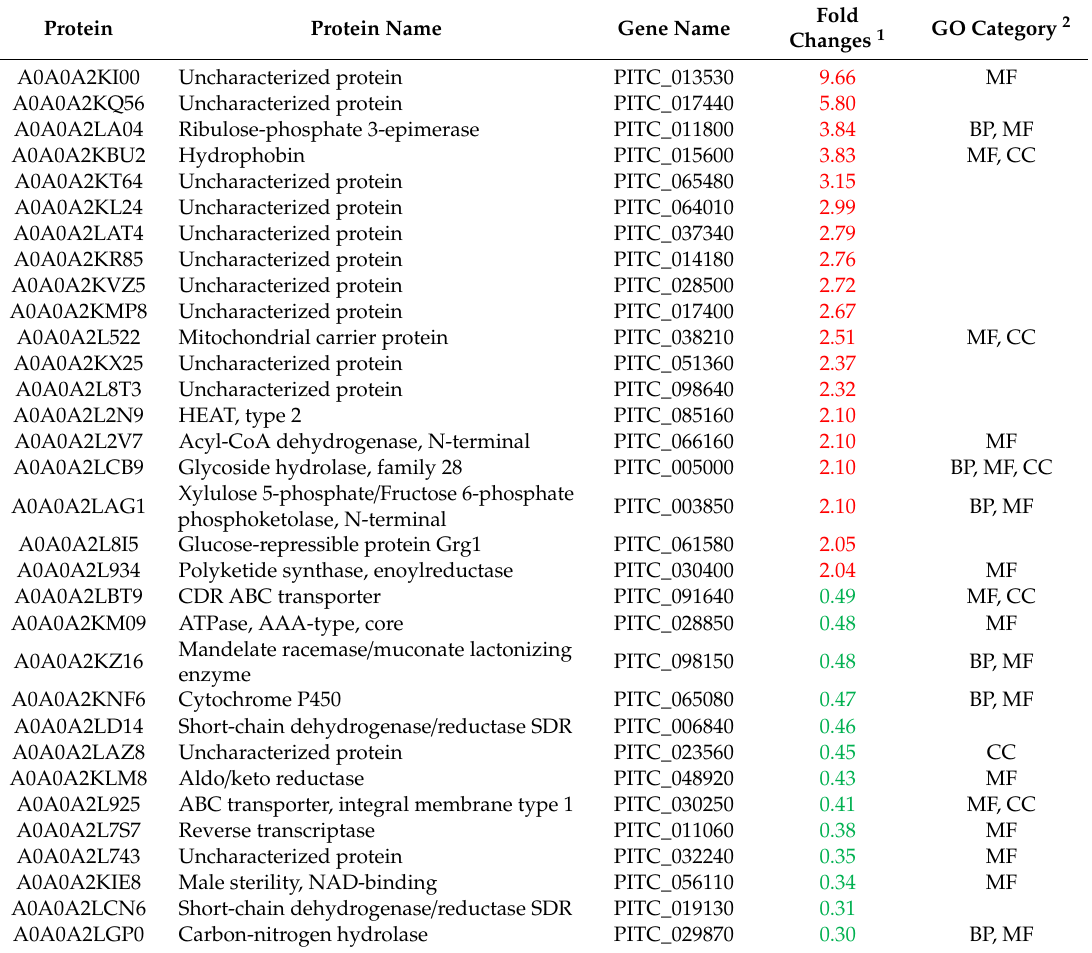
Table 2. The DEPs in di ff erent